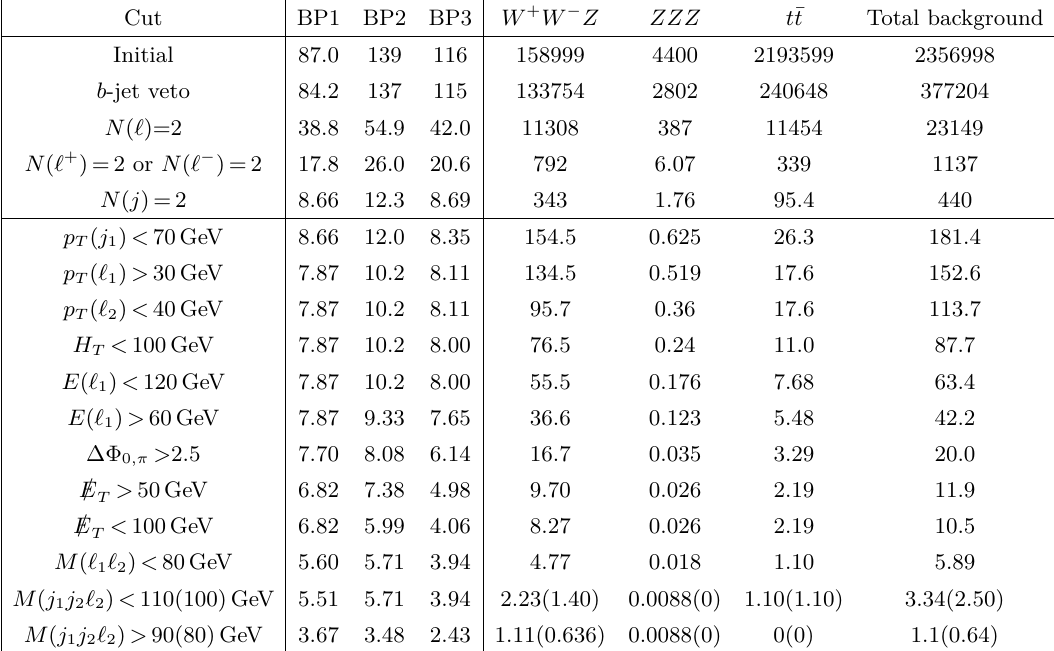
Table 4 . The cutflow for the signal BPs and all background. The luminosity is 4000 fb − 1 and the √ energy is s = 500 GeV. The bracket stands for the cut and result corresponding to both BP2 and BP3. After these cuts, the significance for BP1 is 3 . 5 σ , for BP2 4 . 4 σ and for BP3 3 . 0 σ